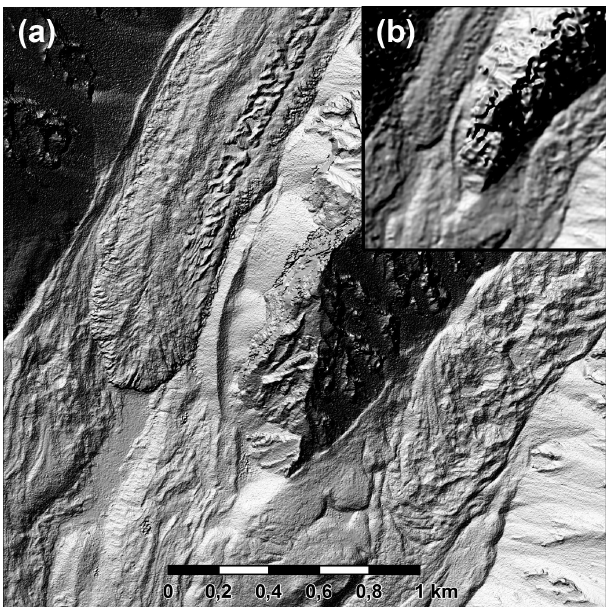
Figure 4. (a) Hillshade of the Pléiades DEM at 1m resolution with advancing tongue of Kuokuosele Glacier (G075156E38175N, left) and stable tongue of glacier G075171E38163N (right), (b) com- pared to 10m DEM of